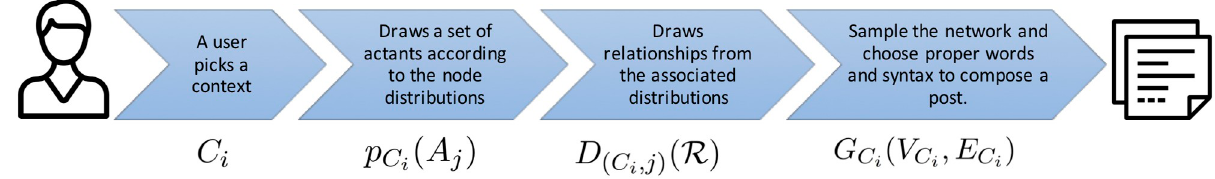
Fig 2. Modeling the steps a user takes to generate a social media post or a story fragment for a given domain.